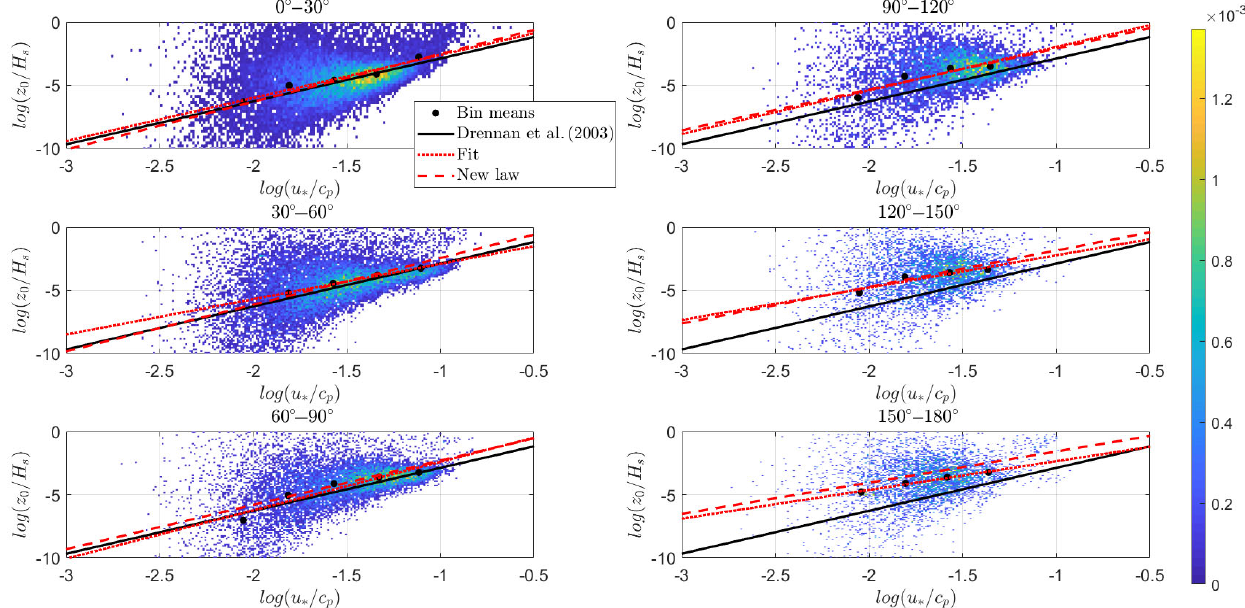
Figure 8. The dimensionless roughness length is plotted against the inverse wave age parameter for six different groups of alignment for the combined ASIT and FINO1 date set. In each figure the data are bin averaged, with the bin means (logarithmic) indicated by black dots. The solid black line represents the roughness length parameterization proposed by Drennan et al. (2003), the dotted red line is the fit through the bin averages and the dashed red line is the new proposed roughness length parameterization. The color scale to the right indicates the probability of occurrence (%) of the measurement